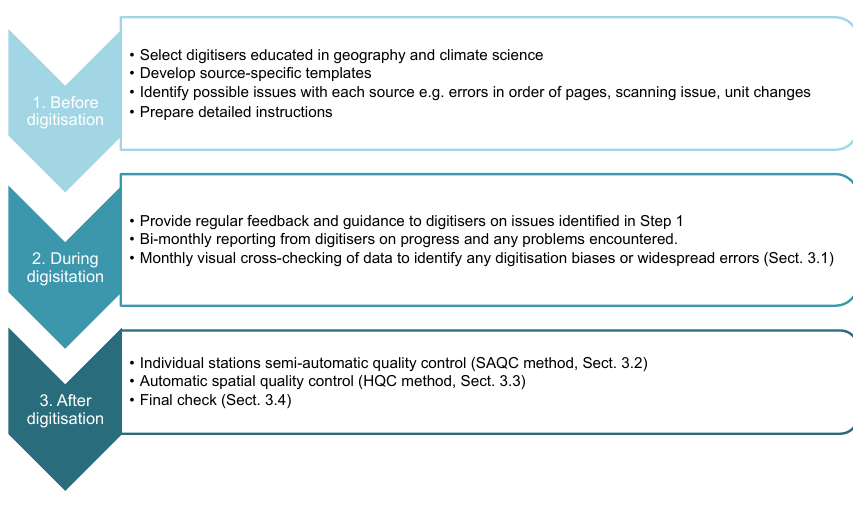
3 Quality assessment of digitised